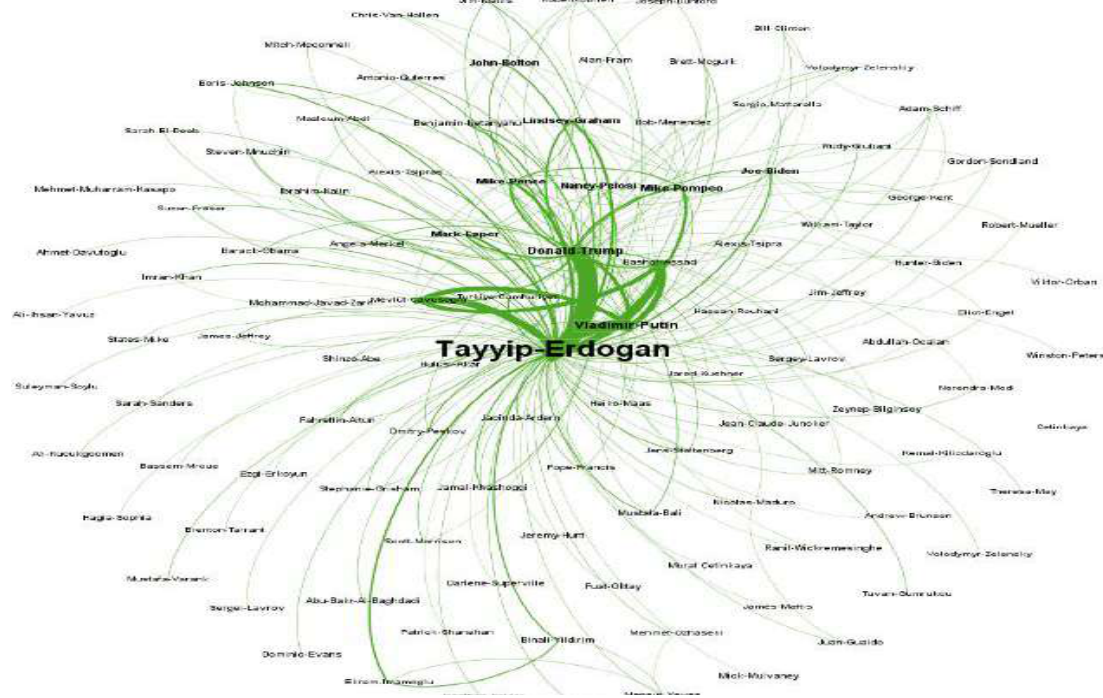
Figure 6: 2019 Network (Source: Authors ‟